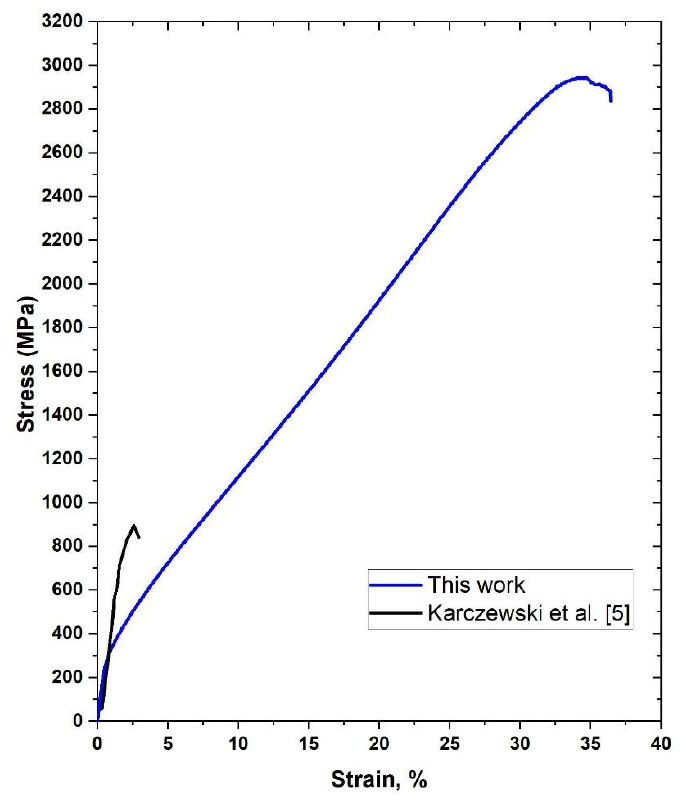
Figure 2. Typical stress-strain curves during the compression test at ambient temperature: black line — based on [5] and blue line — after PAIS sintering.